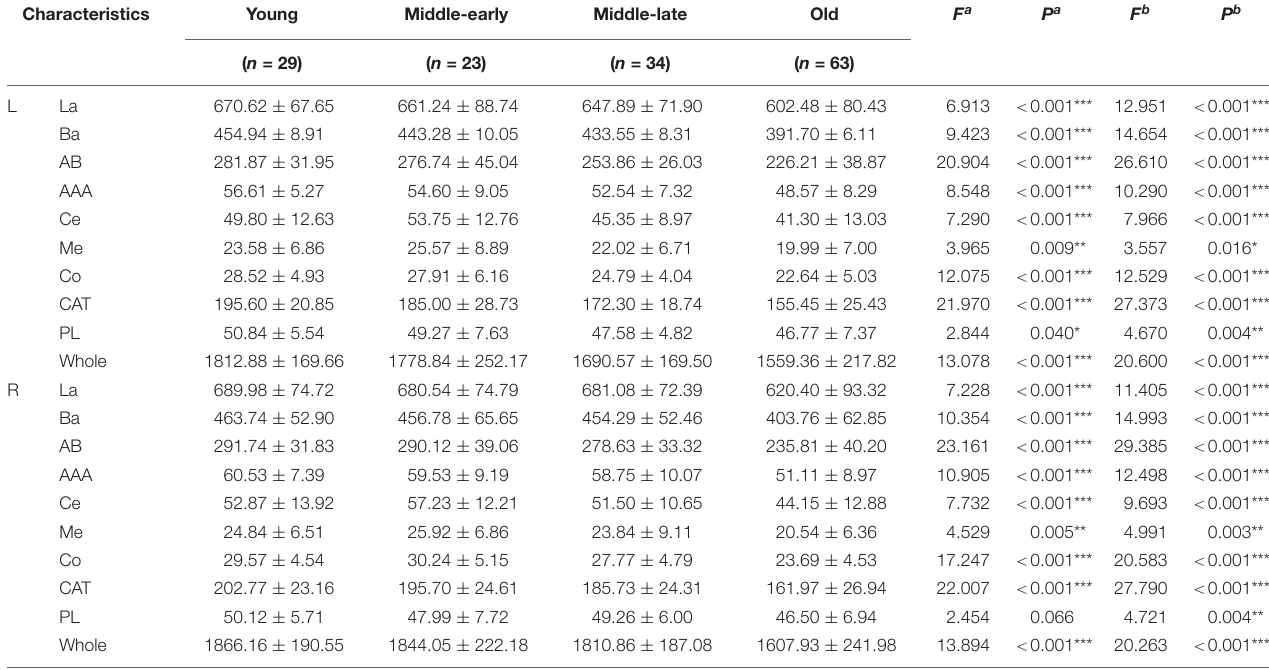
TABLE 4 | Statistical analysis of amygdala and nuclei volumes among the four groups. Characteristics Young Middle-early Middle-late